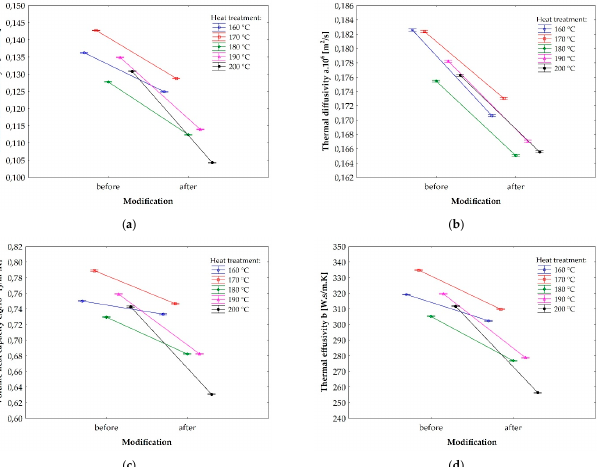
Figure 6. Graphic visualization of the effect of heat treatment temperature on ( a ) thermal conductivity, ( b ) thermal diffusivity, ( c ) volume heat capacity, and ( d ) thermal effusivity. Significance level is at a 95%.